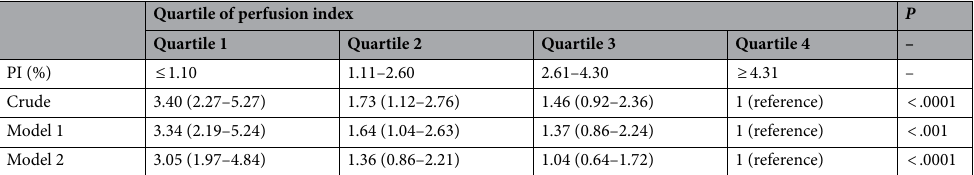
Table 4. Unadjusted hazard ratios and multivariate adjusted hazard ratios for cardiovascular death or recurrent cardiovascular events. PI, perfusion index. Model 1 is adjusted for sex, age, body mass index, heart rate, creatinine and smoking status. Model 2 includes all variables in Model 1 plus duration of diabetes, systolic blood pressure, hemoglobin A1c, total cholesterol, anti-platelet therapies, renin-angiotensin system inhibitor, glucagon-like peptide-1 agonists, sodium-glucose cotransporter 2 inhibitor and